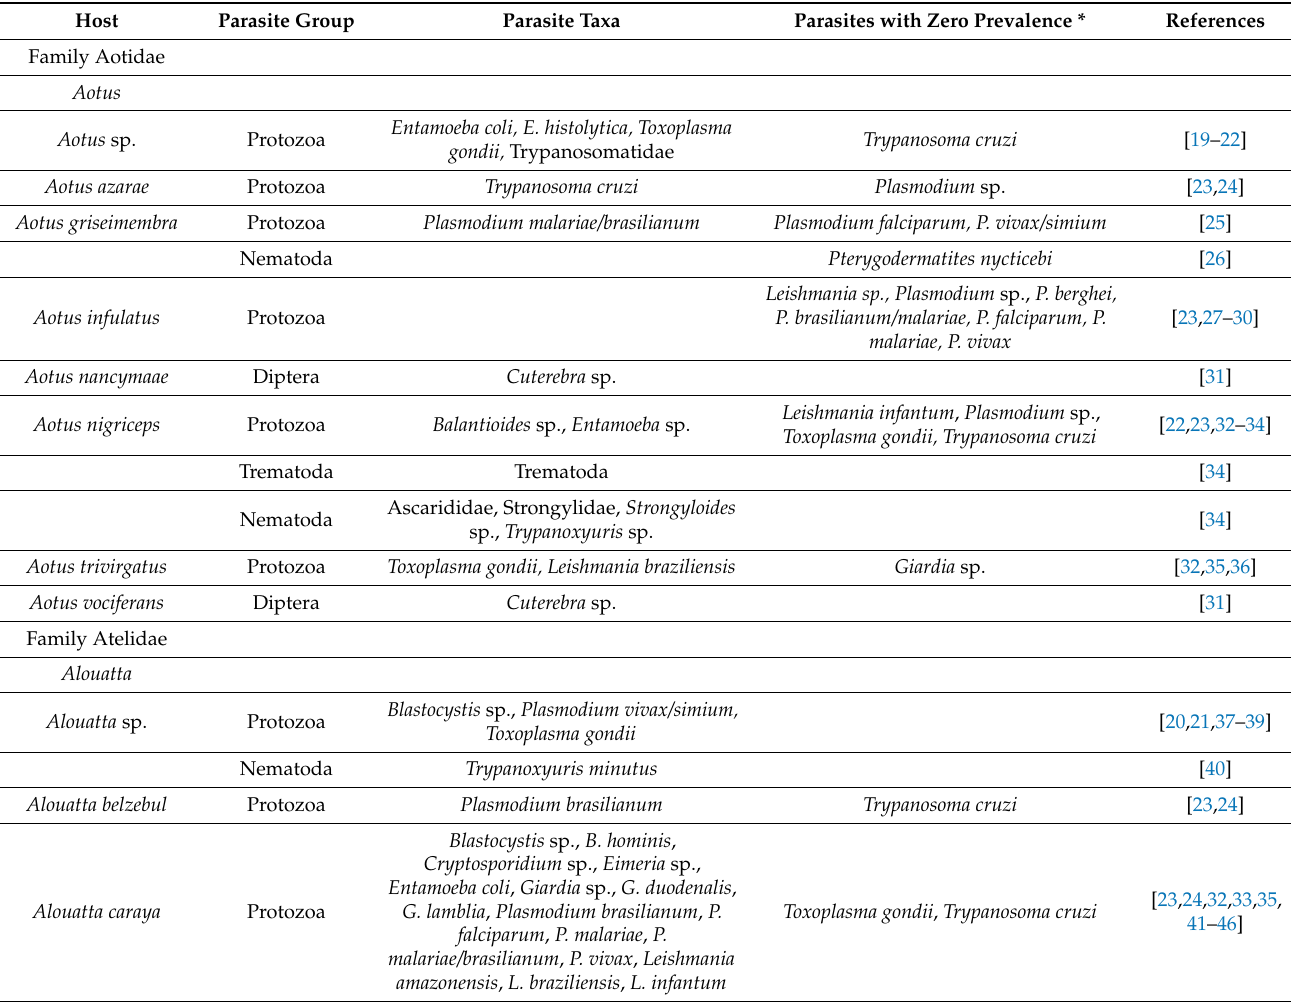
Table 3. Parasites reported per non-human primate species. Parasites’ names were included exactly as reported in the retrieved